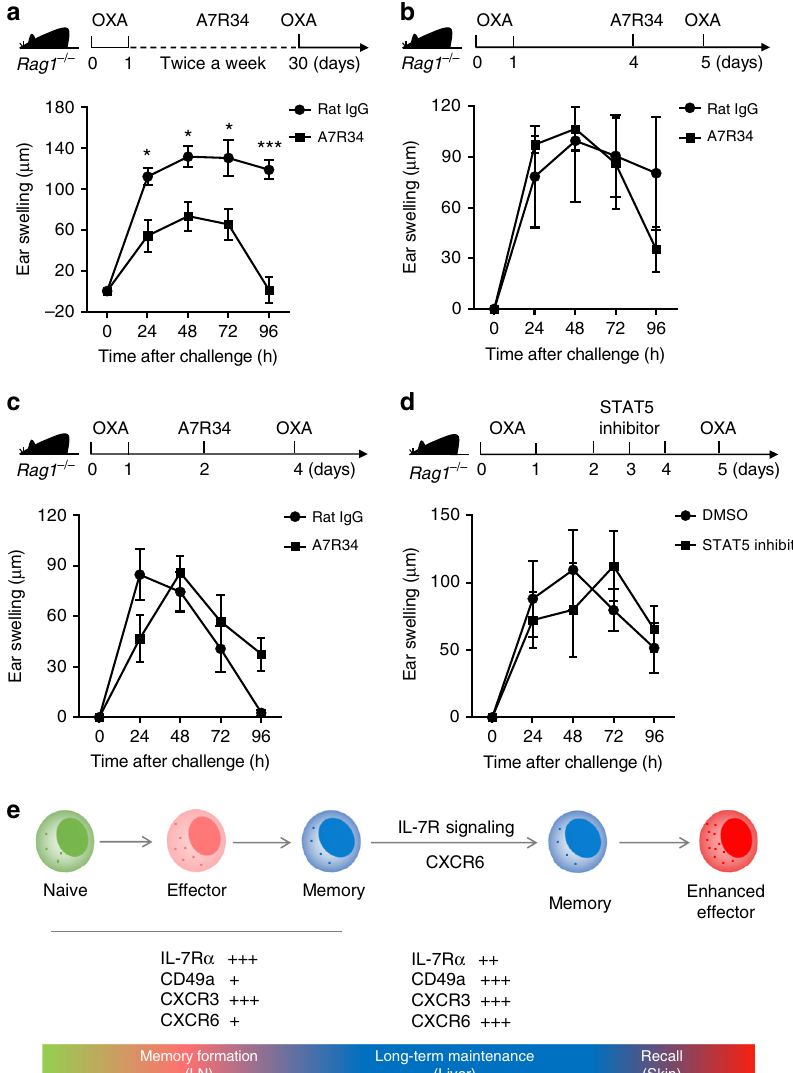
Fig. 7 IL-7R signaling is required for long-term maintenance of memory ILC1s. a Ear swelling of Rag1 − / − mice that were i.p. injected with A7R34 antibody twice a week for 4 weeks, followed by OXA challenge ( n = 5 in each group). b Ear swelling of Rag1 − / − mice i.p. injected with A7R34 antibody 24 h before OXA challenge ( n = 3 – 4 in each group). c Ear swelling of Rag1 − / − mice i.p. injected with A7R34 antibody on day 2 and challenged on day 4 after sensitization ( n = 4 in each group). d Ear swelling of Rag1 − / − mice that were i.p. injected with STAT5 inhibitor daily since day 2 and challenged on day 5 after sensitization ( n = 4 in each group). e Summary of the generation and maintenance of memory ILC1s. Means ± SEM are shown. * P < 0.05, *** P < 0.001, two-tailed unpaired Student ’ s t (Fig. 6b, e). The chemical, FTY720, blocks lymphocyte egress from LNs by inhibiting sphingosine-1-phosphate receptor 1 (S1PR1), leading to retention of lymphocytes in LNs 42 . We found that IL-7R α + ILC1s were increased in the LNs of FTY720-treated mice (Supplementary Fig. 8a, b), suggesting that IL-7R α + ILC1 egress from LNs relies on S1PR1, similar to T cells. Moreover,